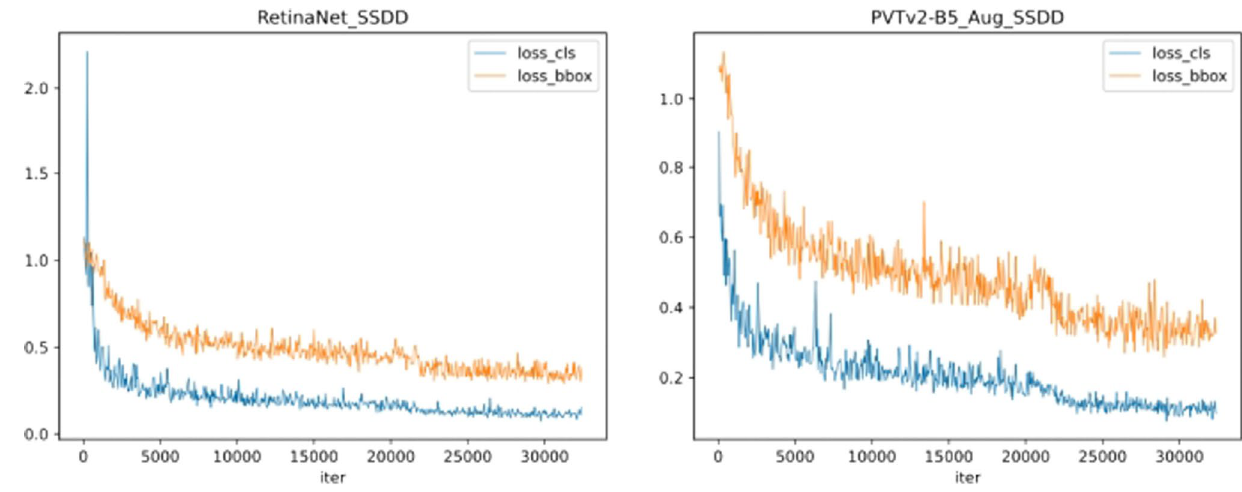
Fig. 6 Loss curve for ablation experiments on SSDD